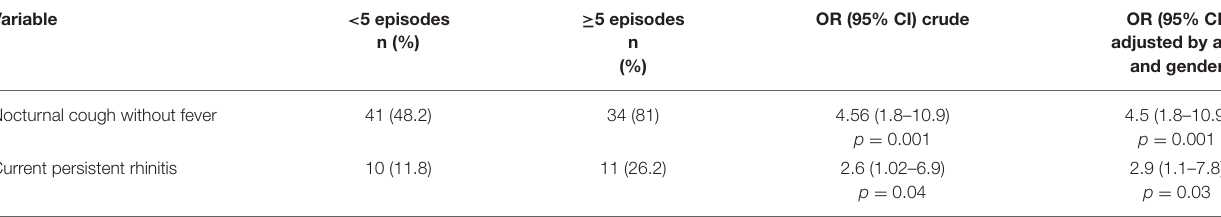
TABLE 4 | Factors associated with hospitalization in the previous year due to wheezing ( n = 127). Variable No n (%) Yes